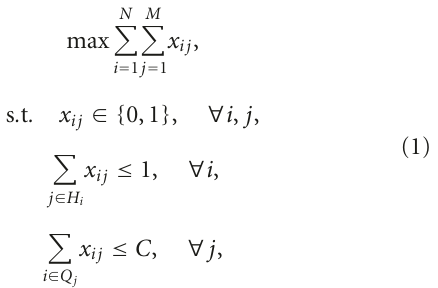
Figure 4: An example of three feasible circles mutually intersected, representing, respectively, as the round area with skew strips, horizontal strips, and points. The overlap area of the three circles in the middle represents the placement region where one RN can cover the three